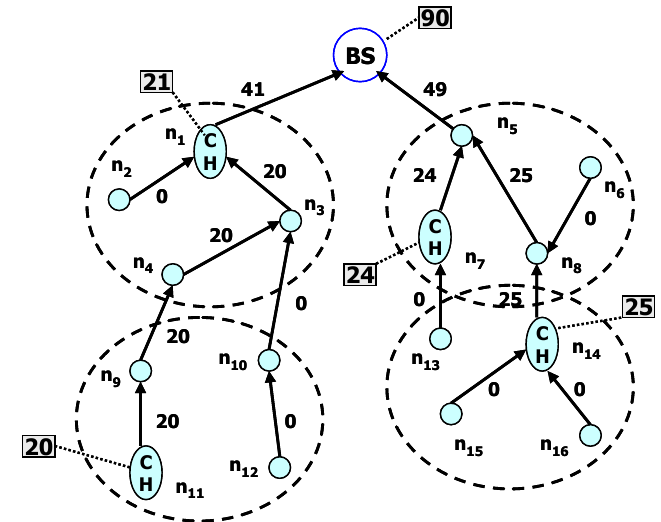
Figure 4. Aggregation of four-cluster